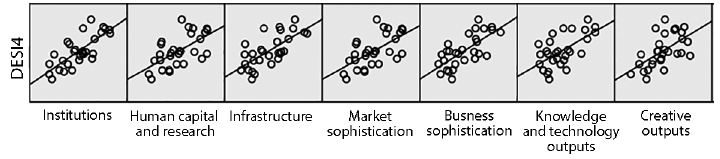
Figure 1. The relationship between DESI4 and the 7 pillars of